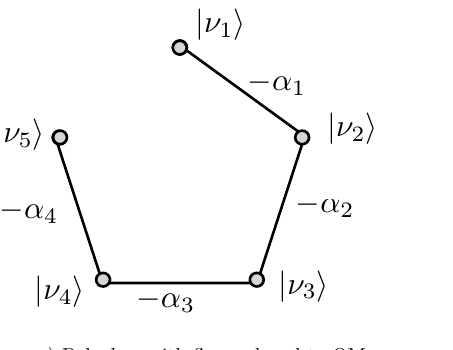
Figure 2 . Dimensional reduction of SU( N ) Polyakov and dYM with the insertion of ’t Hooft flux down to quantum mechanics on T 2 × R and T 2 × R × S 1 , respectively. N = 5 above. Both theories have N -perturbative vacua, N − 1 ( N ) monopoles are associated with the simple (affine) root systems. In the absence of ’t Hooft flux, there is a unique perturbative vacuum and monopoles of the QFT do not survive in QM limit in Born-Oppenheimer